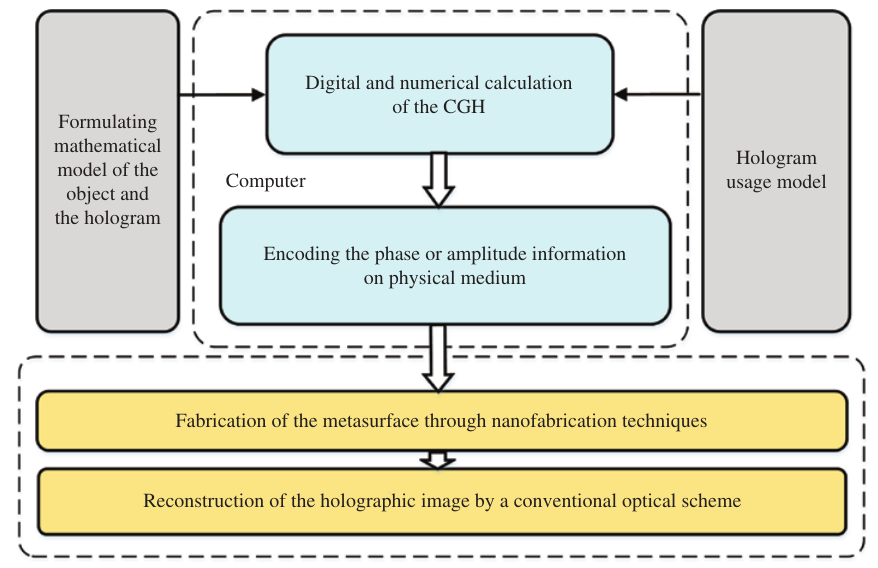
Figure 1: Typical procedures required for the design and demonstration of optical metasurface holography. One important step is the suitable selection of the phase encoding method, which influences the subsequent fabrication